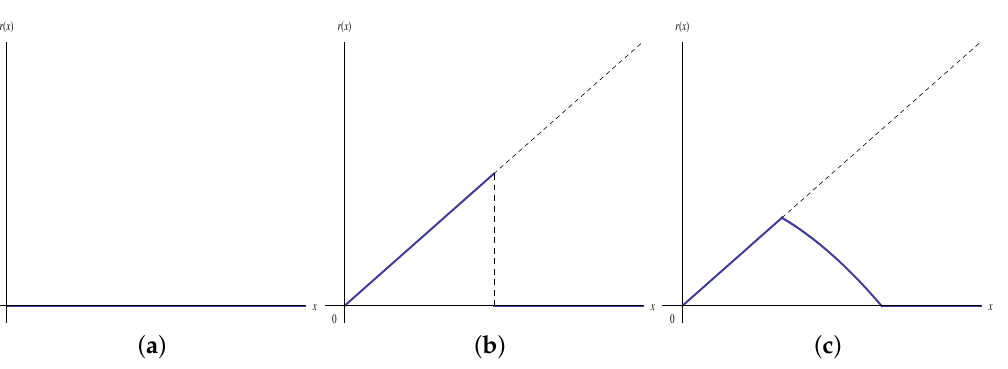
Figure 3. Three possible structures of optimal indemnity function r ∗ . ( a ) noninsurance; ( b ) full insurance followed by noninsurance; ( c ) full insurance followed by coinsurance insurance and then